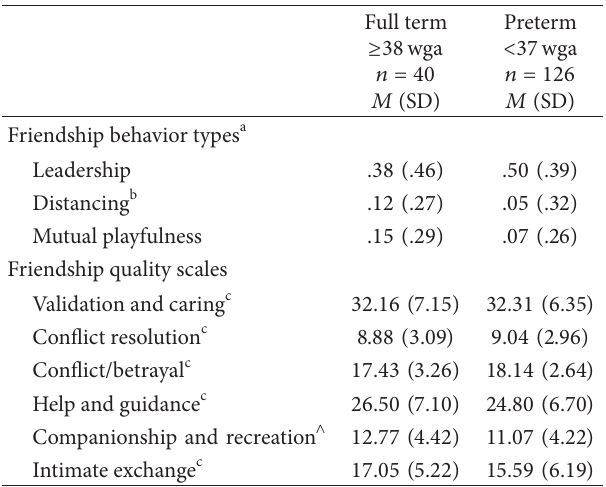
T 4: Mean scores of friendship behavior types and friendship quality scales at age 12 by prematurity